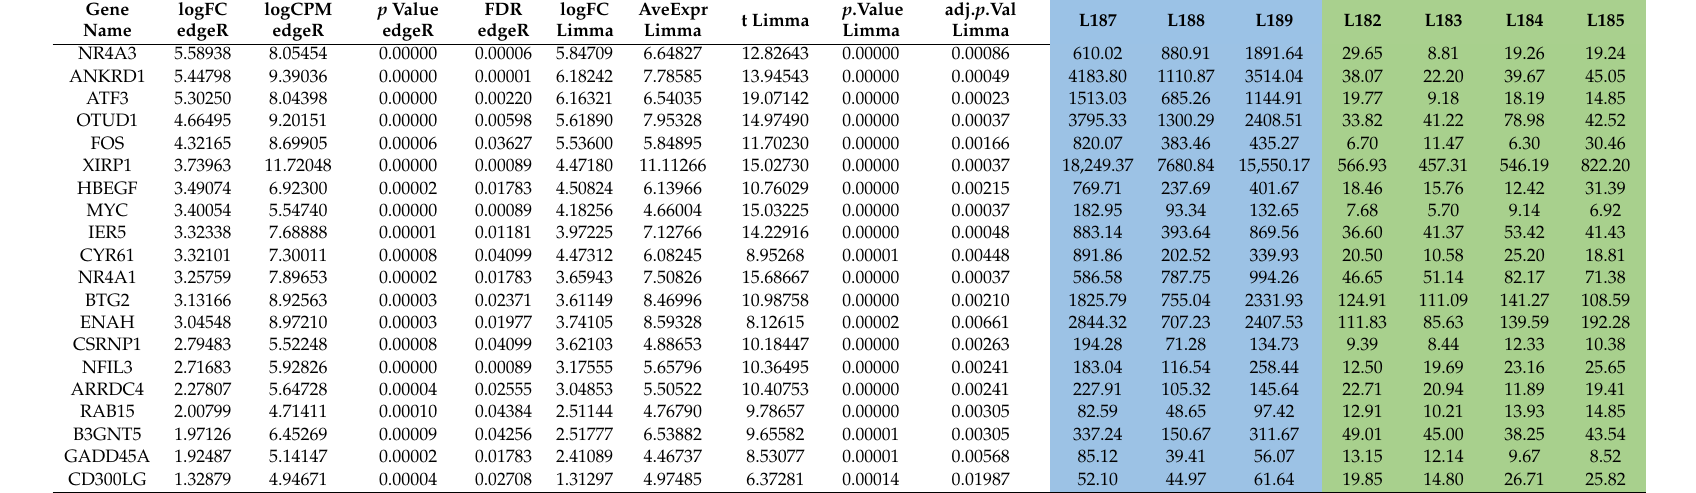
Table 5. Genes characterizing the two groups of trained subjects.